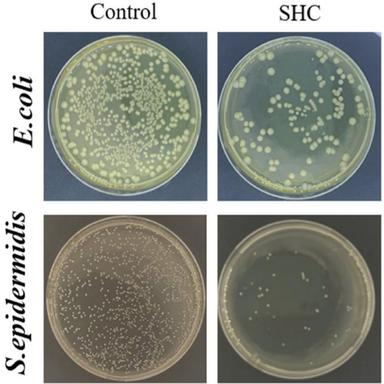
Representative colonization of E. coli and S. epidermidis on two groups of samples.